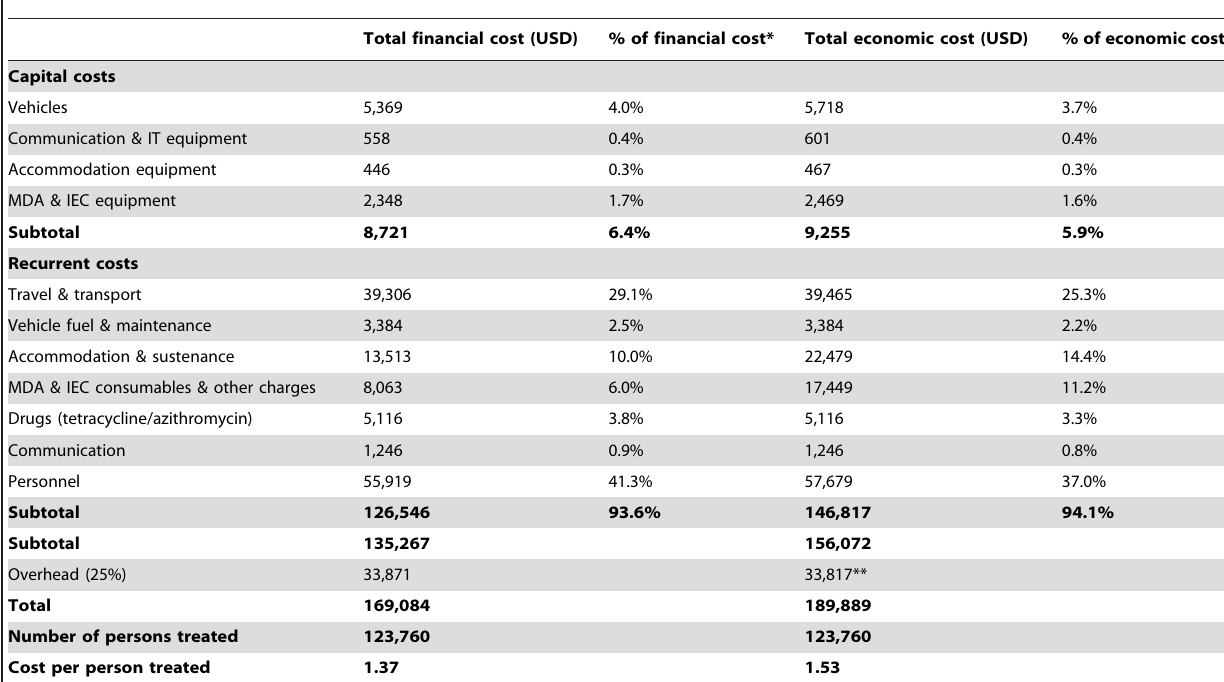
Table 1. Financial and economic costs, and associated cost profiles, for antibiotic MDA in Mayom County.